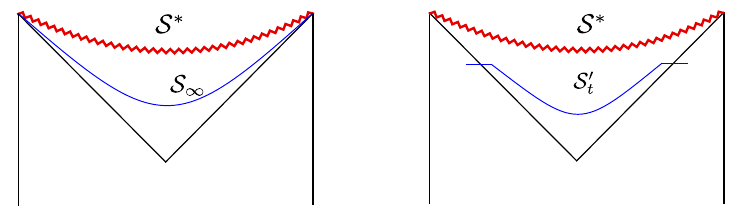
Figure 1 . On the left, the codimension-one asymptotic surface S ∞ , accounting for the total complexity ‘flowing’ into the black-hole singularity S ∗ . On the right, the subtracted codimension- one surface S ′ t which accounts for the time-dependence of VC complexity in the eternal black hole